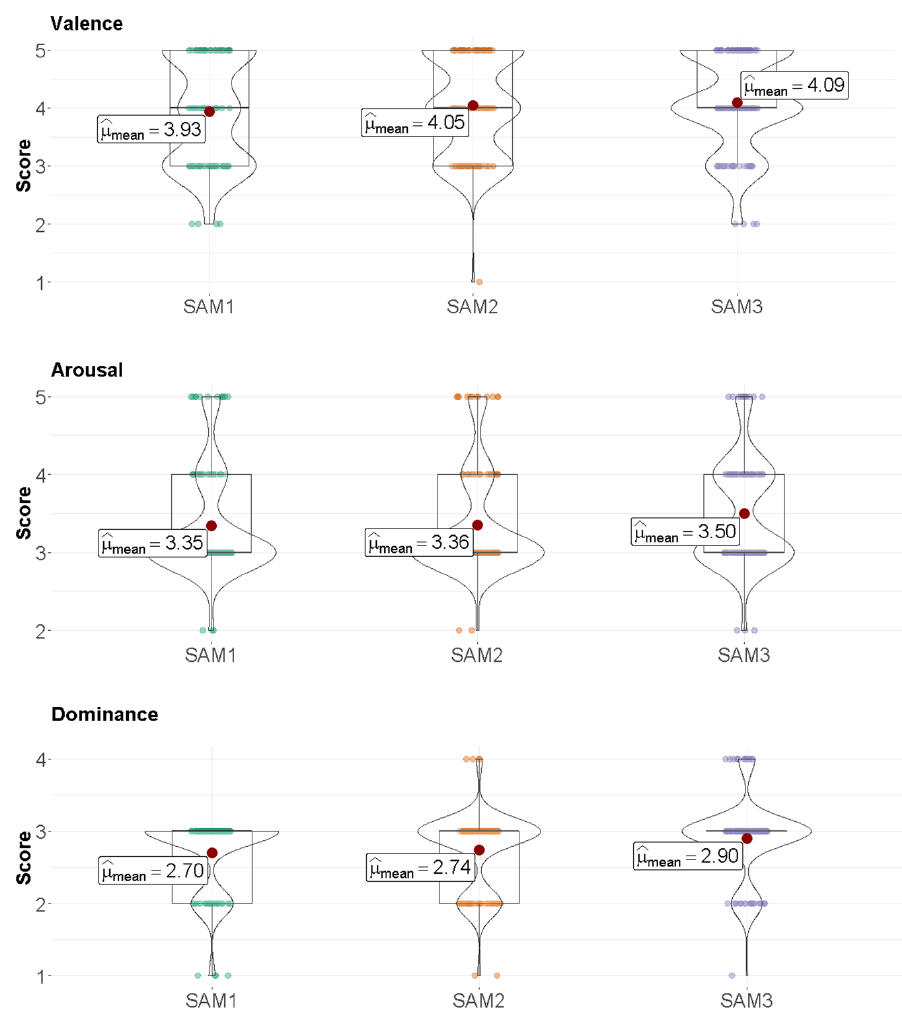
Figure 9. Boxplot of the results for the SAM1, SAM2 and SAM3 tests responses.